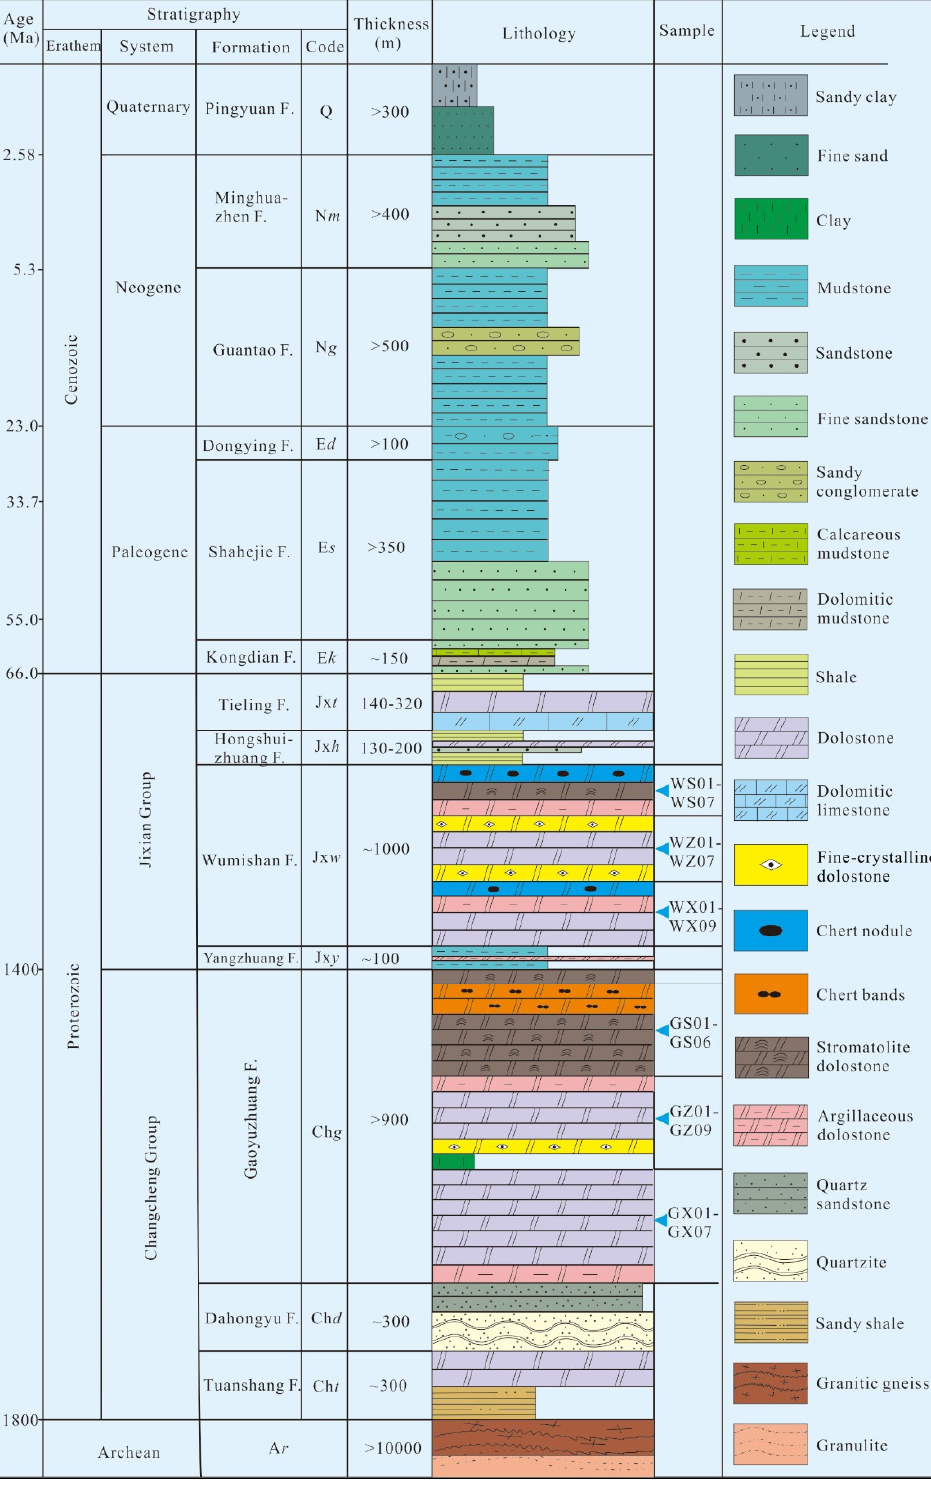
Figure 2. Lithological column of the study